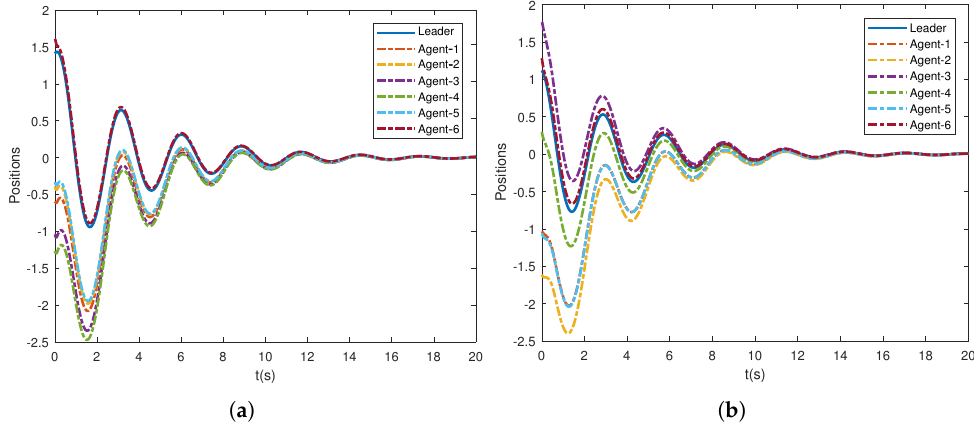
Figure 2. Consensus of positions under different topologies. ( a ) Positions of the leader and followers under G 1 ; ( b ) positions of the leader and followers under G 2